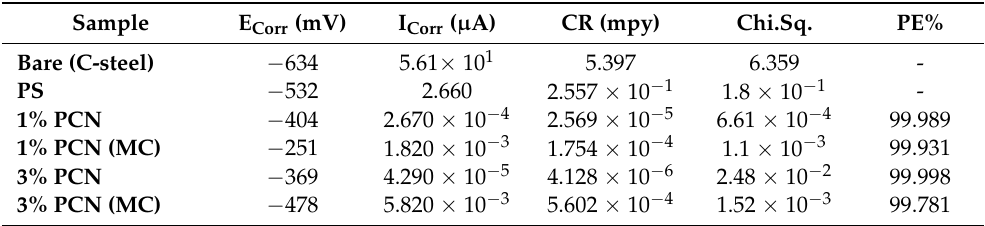
Table 5. Tafel parameters of bare C-steel, PS, 1% PCN, 3% PCN, 1% PCN (MC) and 3% PCN